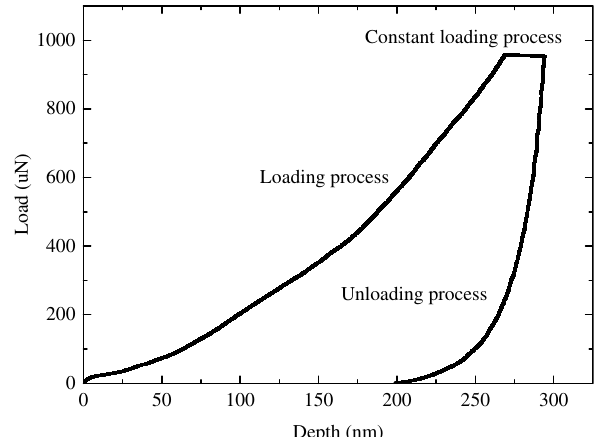
Figure 2. Load-depth curve of nanoindentation.